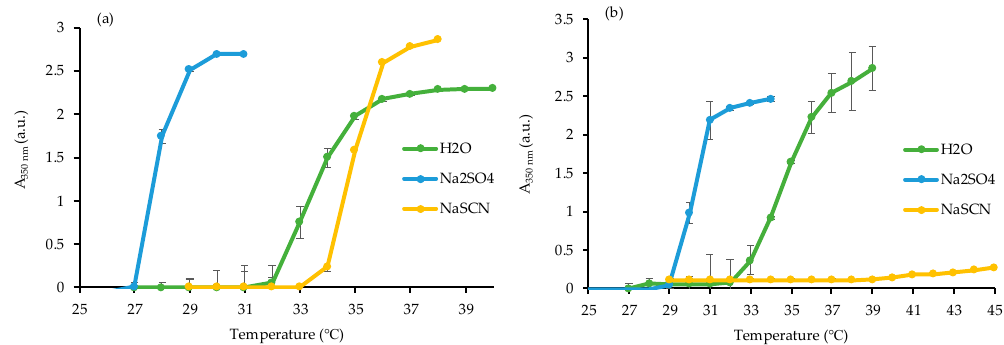
Figure 1. Absorbance (A 350 ) as a function of temperature for ( a ) F1 and ( b ) R1 in deionized water, 0.1 M Na 2 SO 4 , and 0.1 M NaSCN solutions.